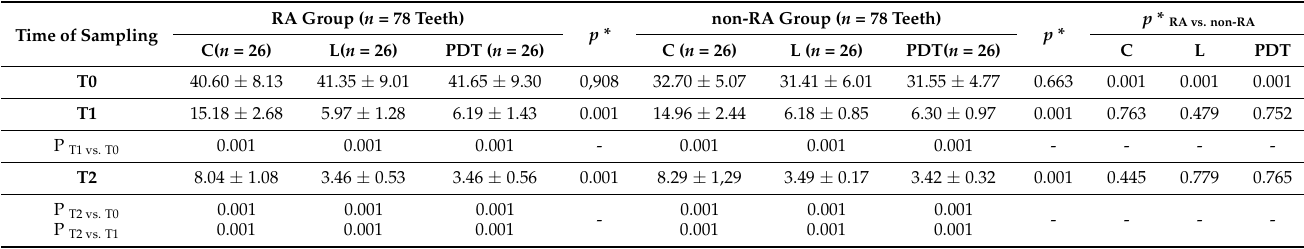
Table 3. Mean values of